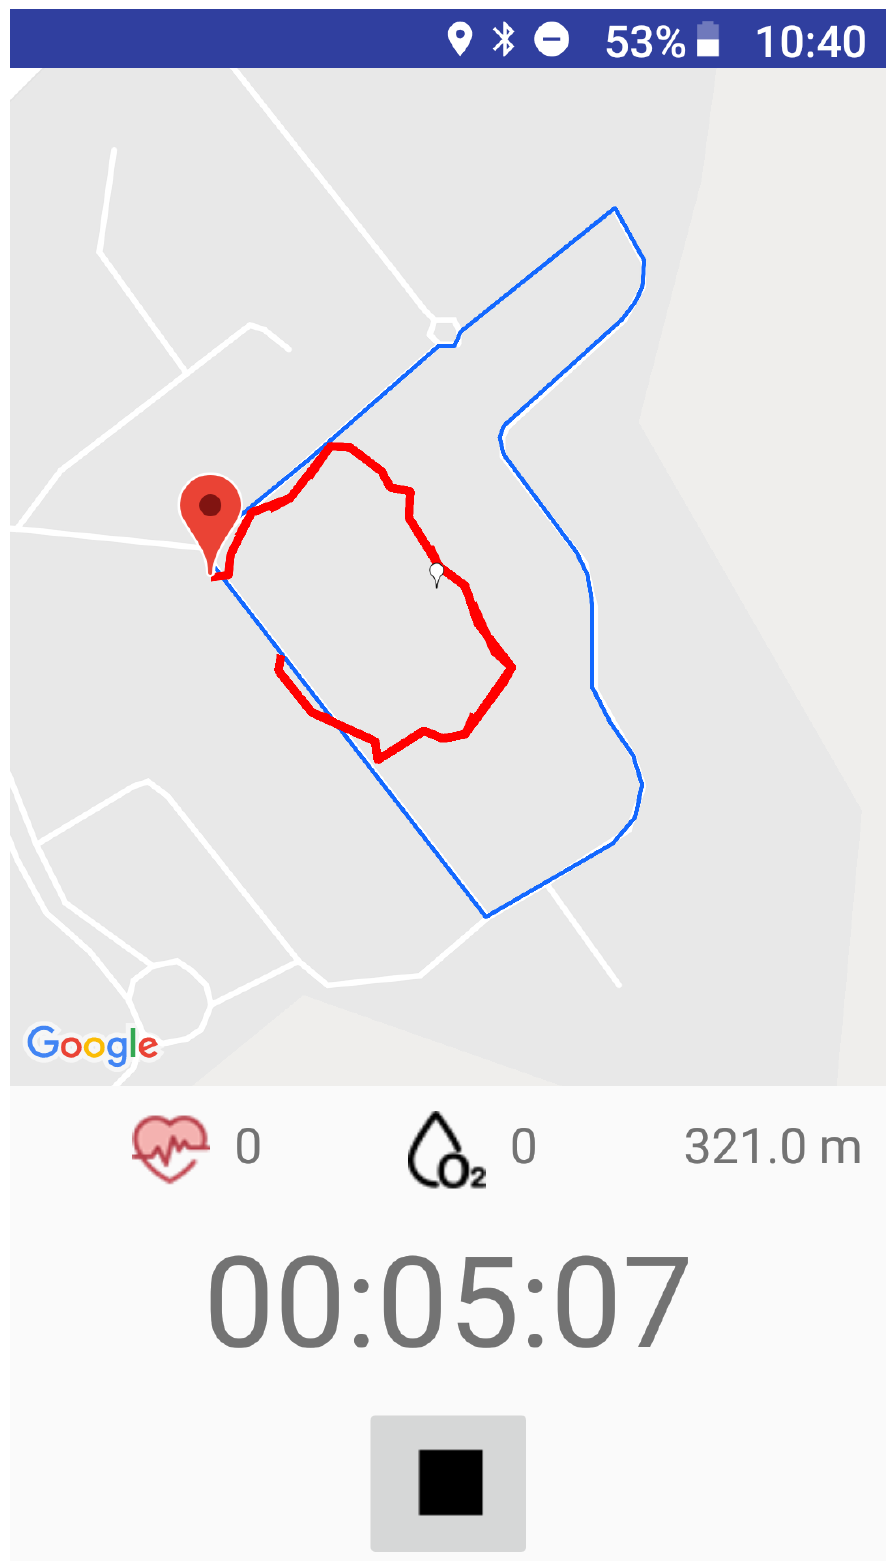
Figure 2. Route screen.